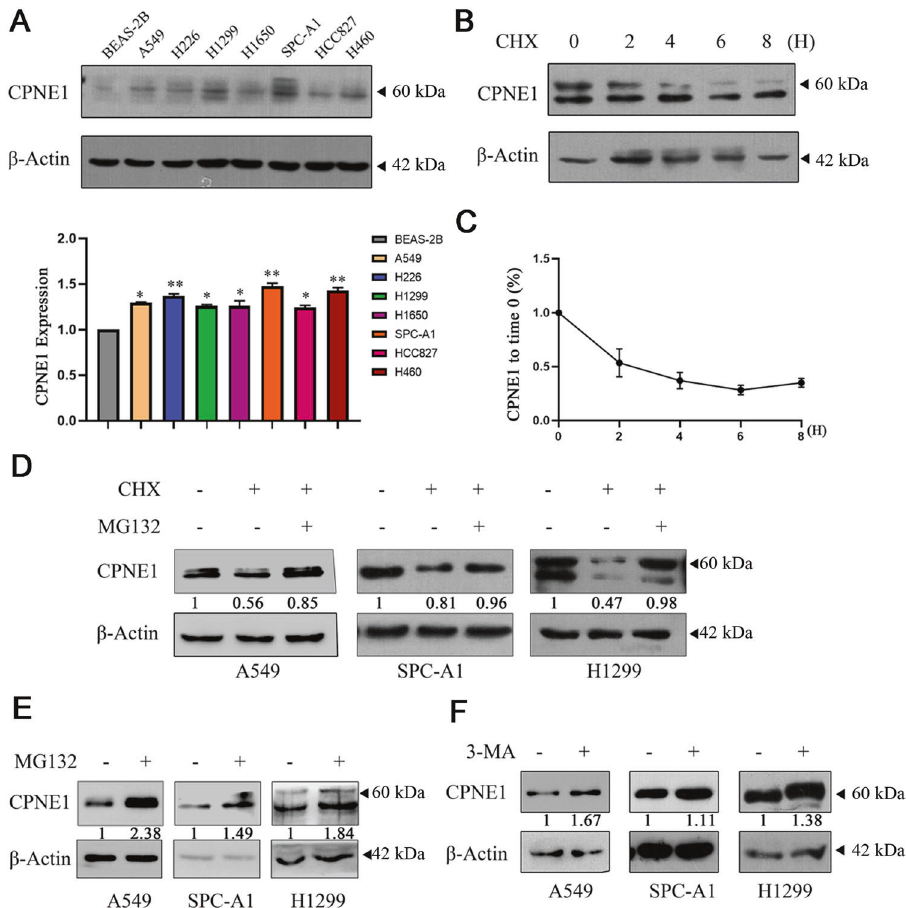
Fig. 2 CPNE1 is degraded through both the ubiquitin-proteasome pathway and the autophagy-lysosome pathway. A CPNE1 was highly expressed in lung cancer cell lines. B , C CPNE1 was rapidly degraded in HEK293T cells. HEK293T cells were transfected with the Flag-CPNE1 plasmid. After 48 h, cells were treated with 100 µg/ml cycloheximide/vehicle for the indicated times. Cell lysates were prepared for Western blot analysis. The relative density of the CPNE1 band was measured with ImageJ software. D The degradation of CPNE1 mediated by CHX was rescued by MG132. The indicated cell lines were seeded into six-well plates. After 24 h, cells were treated with 100 µg/ml CHX or 100 µg/ml CHX plus 10 µM MG132 for 6 h. Cell lysates were prepared for Western blot analysis. E , F Both MG132 and 3-MA can stabilize CPNE1. The indicated cell lines were seeded into six-well plates. After 24 h, cells were treated with 10 µM MG132 for 6 h and 1 mM 3-MA for 18 h. Cell lysates were prepared for Western blot analyzing the mechanism of CPNE1 protein degradation is of great importance for the functional study of CPNE1. To determine whether this degradation involves the proteasome pathway, we treated lung cancer cells with CHX alone or with both CHX and MG132 to inhibit proteasomal degradation (Fig. 2D). In the absence of MG132, CPNE1 was degraded, while proteasome inhibition by MG132 reversed this degradation, notably stabilizing CPNE1. The above results indicated that degradation of the CPNE1 protein occurred through a proteasome-mediated ubiquitination degradation pathway. Interestingly, to further investigate the degradation of the CPNE1 protein, we evaluated the degradation of endogenous CPNE1 through the lysosomal pathway and the proteasome pathway. The results showed that when MG132 or 3-MA was added, endogenous CPNE1 protein accumulated (Fig. 2E, F). Taken together, these results con fi rm that the CPNE1 protein is degraded by both the ubiquitin-proteasome pathway and the lysosomal pathway in lung cancer cells. CPNE1 undergoes ubiquitination, and a highly conserved lysine at position 157 is subjected to ubiquitination To gain further insight into the mechanism of CPNE1 degradation, we evaluated whether CPNE1 is conjugated with Ub in vivo.